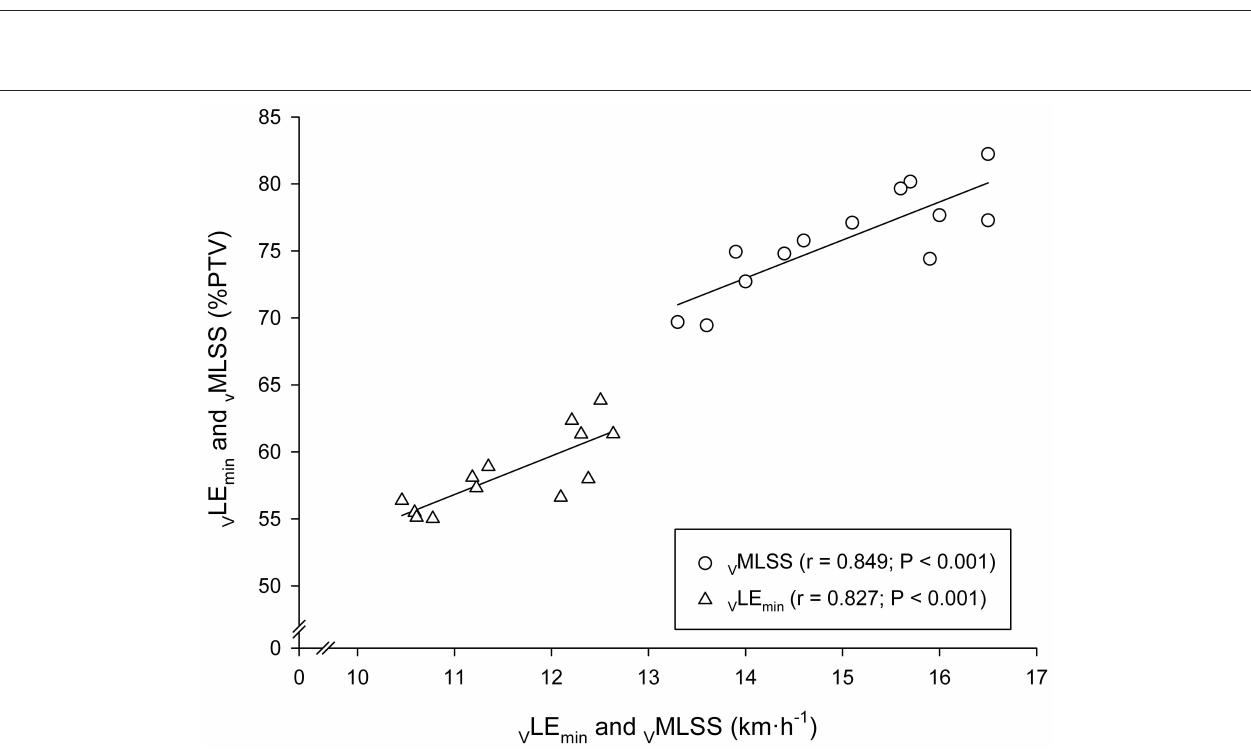
FIGURE 5 | Linear regressions between the velocities at the Minimum Lactate Equivalent ( V LE min ) and Maximal Lactate Steady State ( V MLSS) in absolute values (km · h − 1 ) with their respective velocities relative to peak treadmill velocity (PTV).